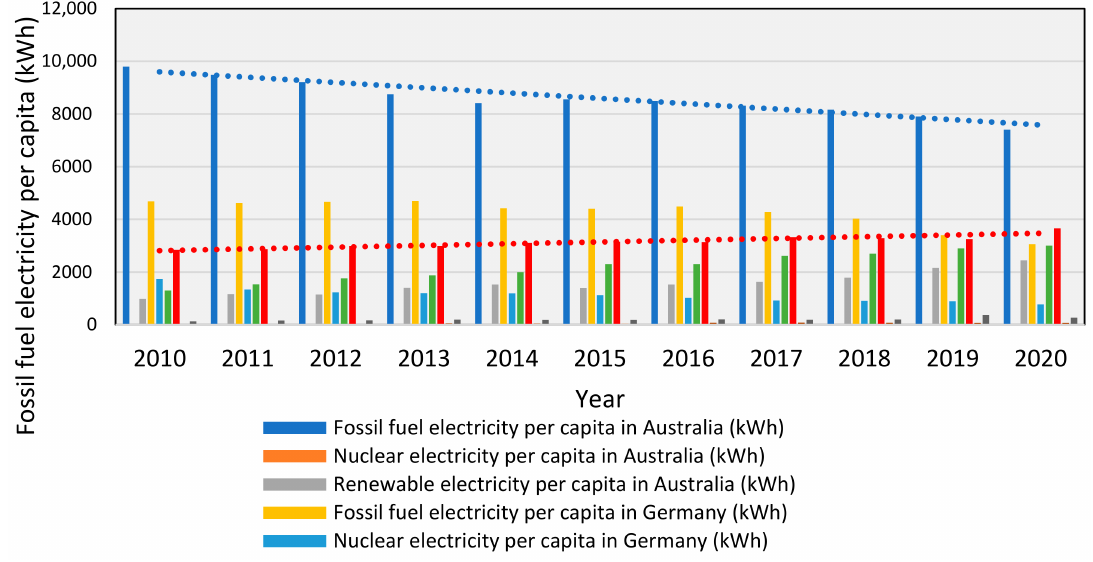
Figure 9. Fossil fuel electricity per capita (kWh) of Iran, Australia, and